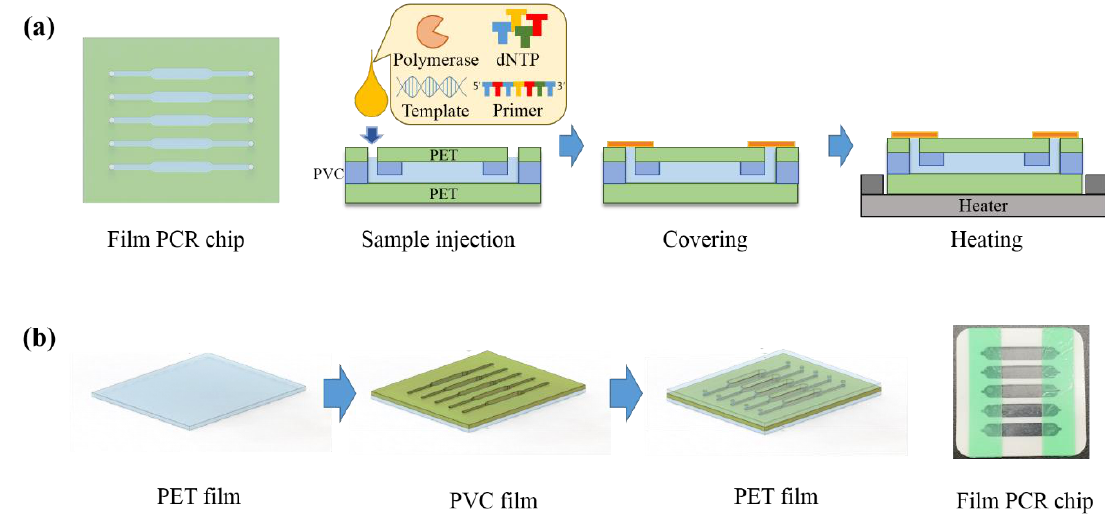
Figure 1. ( a ) Schematic illustration of gene amplification by using the film polymerase